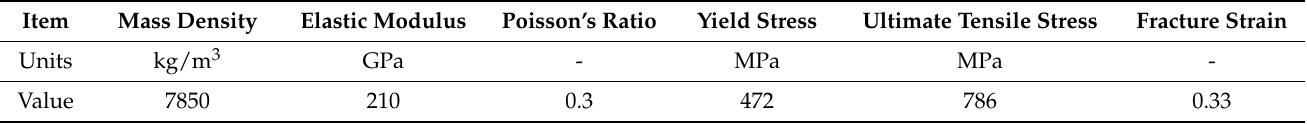
Table 1. Mechanical properties obtained by quasistatic tensile